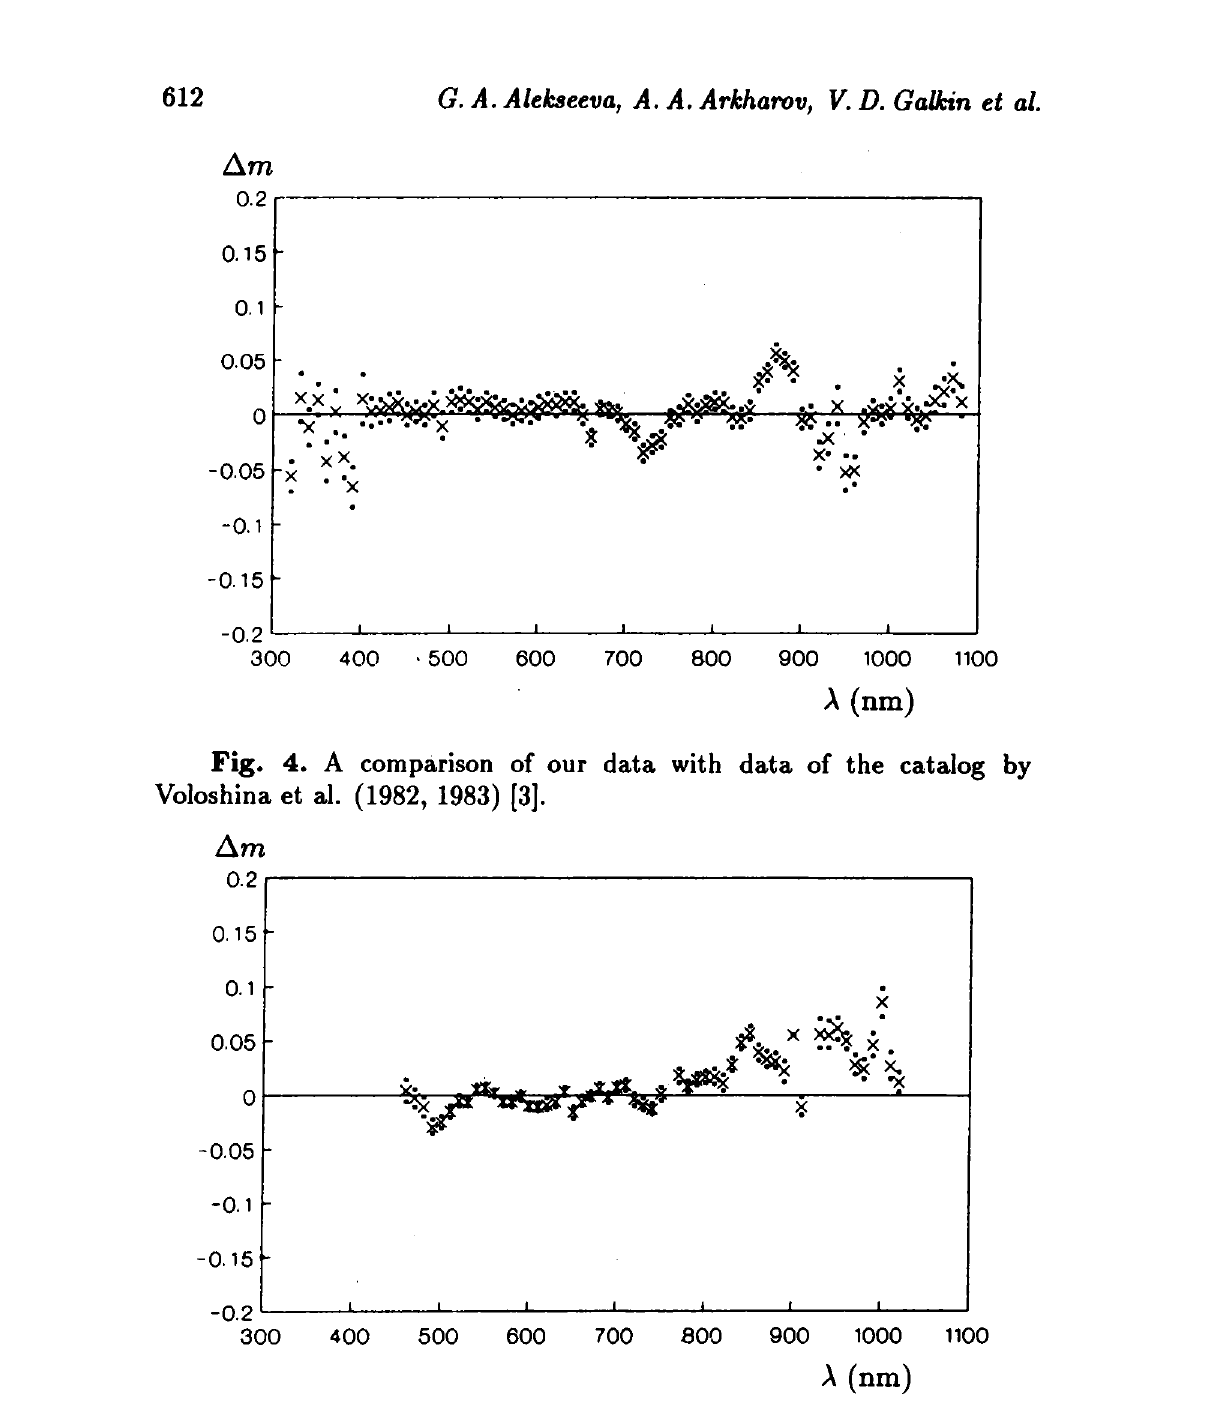
Fig. 5. A comparison of our data with data of the catalog by Cochran (1980)